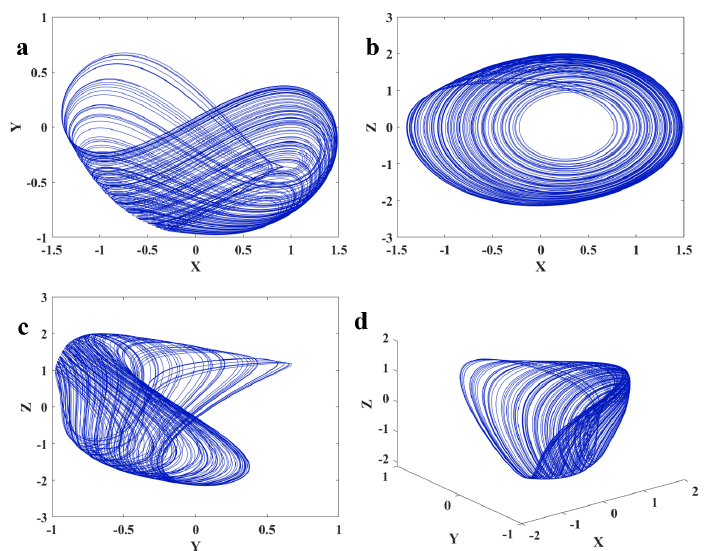
Figure 2. The chaotic dynamics of Equation (1) with a = 0 and ( x 0 , y 0 , z 0 ) = ( 0,0,0 ) in ( a ) X − Y ;